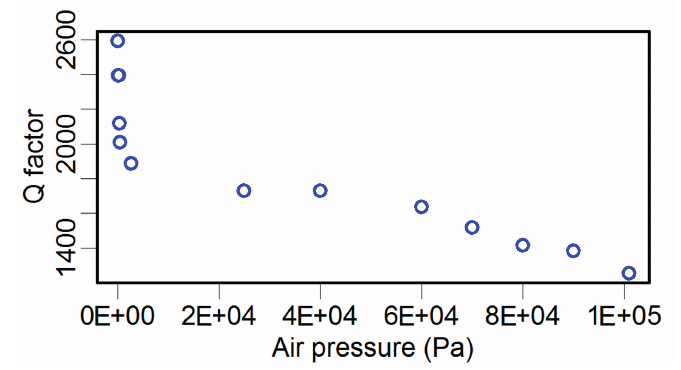
Figure 9. Resonance frequency vs. atmospheric pressure of a TF-probe.